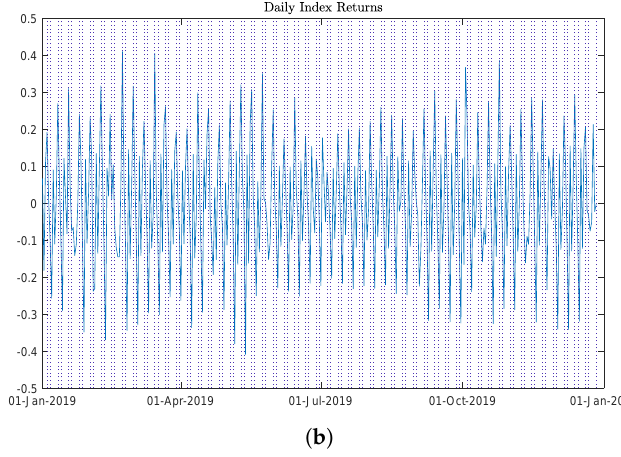
Figure 10. Index value I t , panel ( a ), and Index returns R t , panel ( b ), in